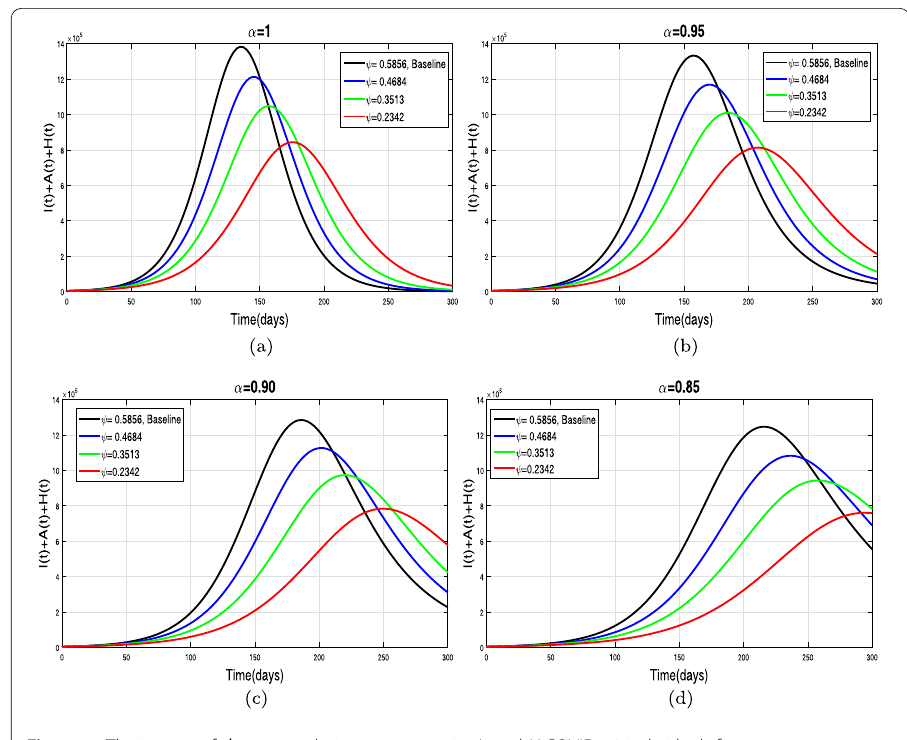
Figure 4 The impact of ψ on cumulative symptomatic, A , and H COVID-19 individuals for α = 1, α = 0.95, α = 0.90, α = 0.85